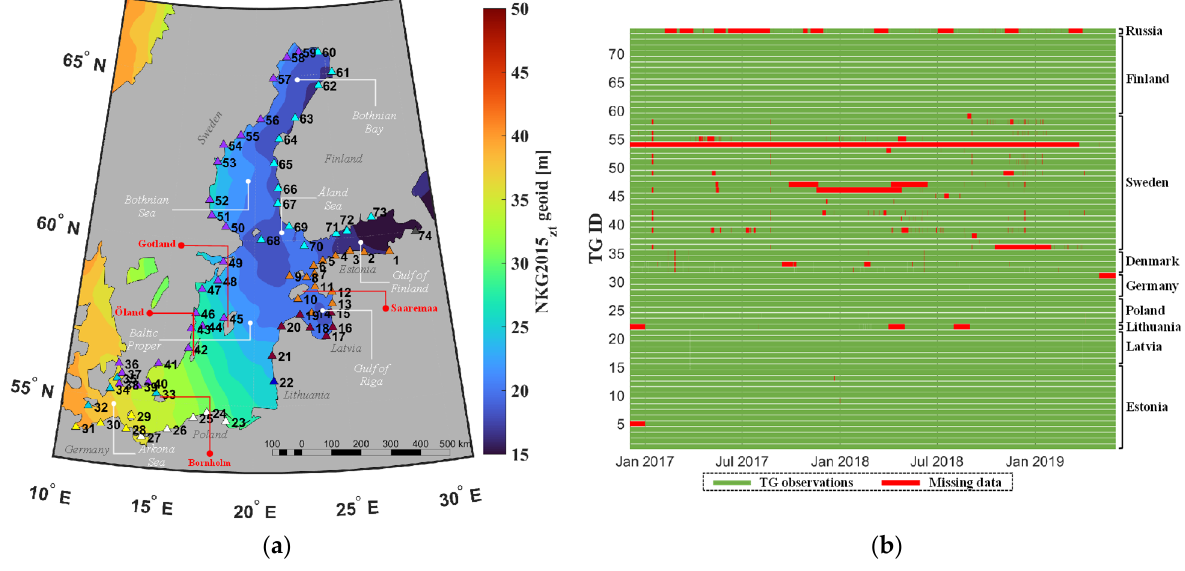
Figure 4. Characteristics of the study area: ( a ) Location of the Baltic Sea (the background represents the NKG2015 geoid model) together with the location of the tide gauges (triangle symbols). The names of sub-basins and main islands are denoted in white and red, respectively. ( b ) TG data availability between December 2016 to April 2019 of each TG ID ( b ). The TG numbering is clockwise, starting from the eastmost Estonian TG station and finishing with the Russian Kronstadt TG station (No. 74), which is located at the eastmost end of the Gulf of Finland.